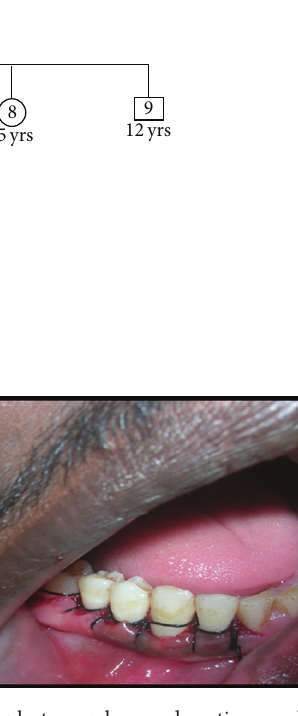
Figure 4: Pocket marker marked the bleeding points that denoted the excess portions of gum of male patient.